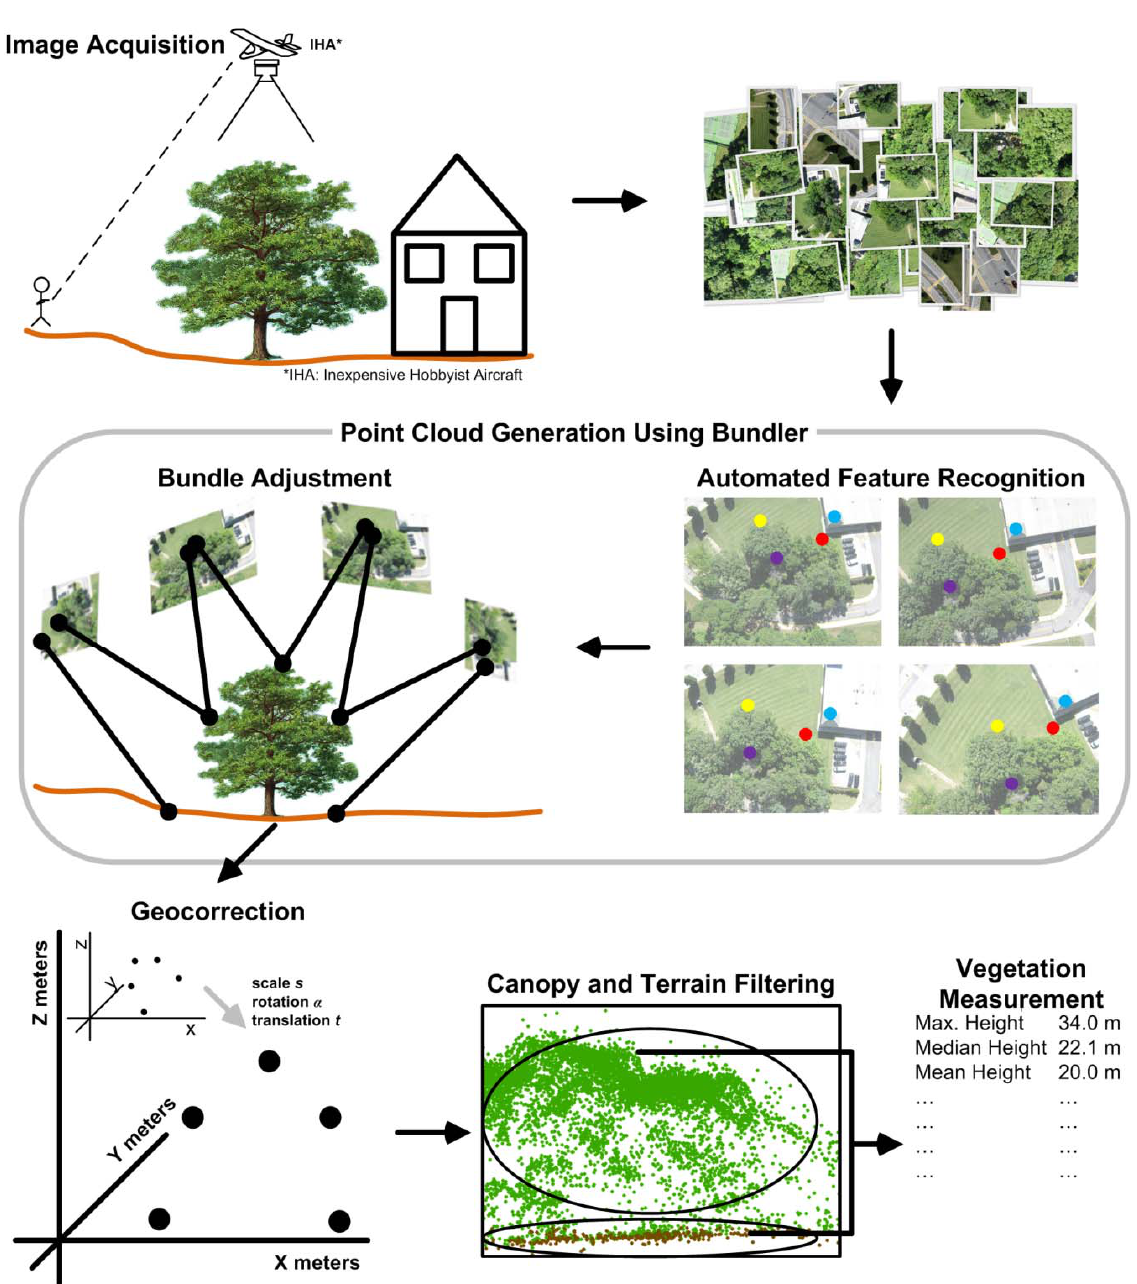
Figure 2. Ecosynth procedure for vegetation measurements using computer